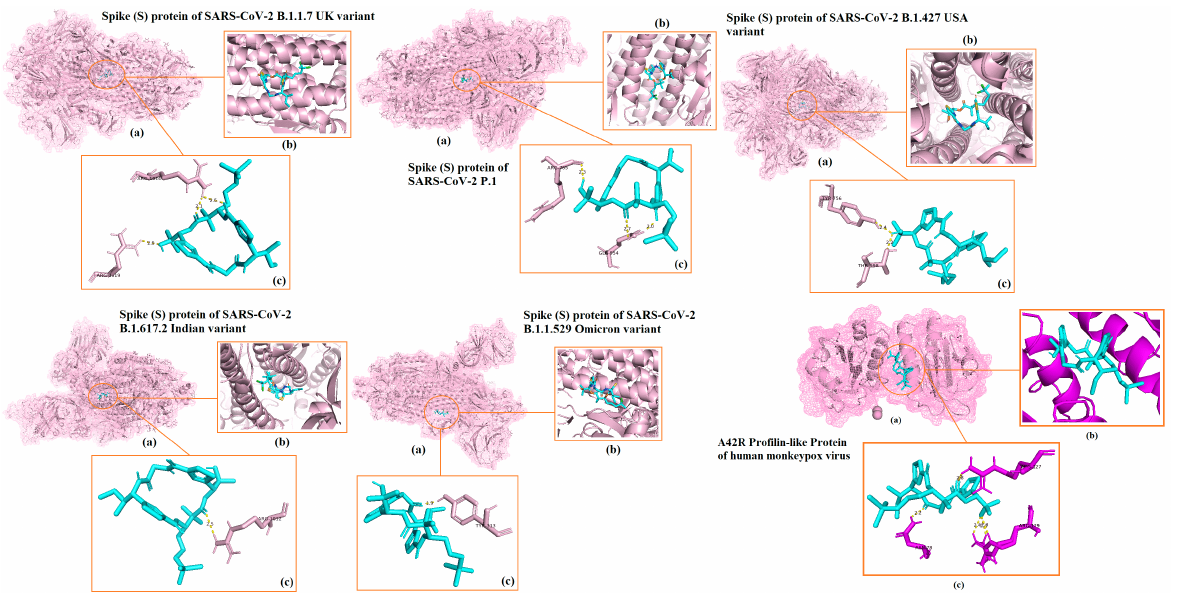
Figure 4. Results of the docking analysis showing the 6 main binding sites of lyngbyabellin A with the different viral surface proteins. The molecular interactions in the 3D structures were visualized in PyMOL. ( a ) Indicates binding domain. ( b ) Binding site. ( c ) Interacting amino acids of receptor (purple) and ligand (blue).